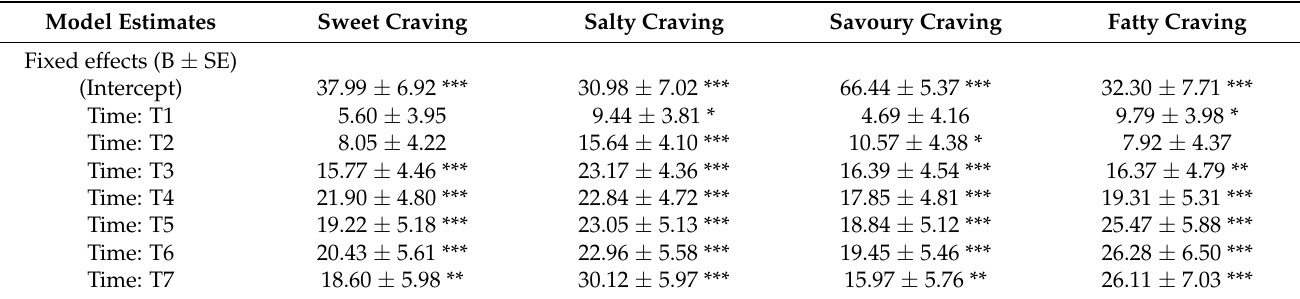
Table 5. Linear mixed effect model estimates and AUC differentials for